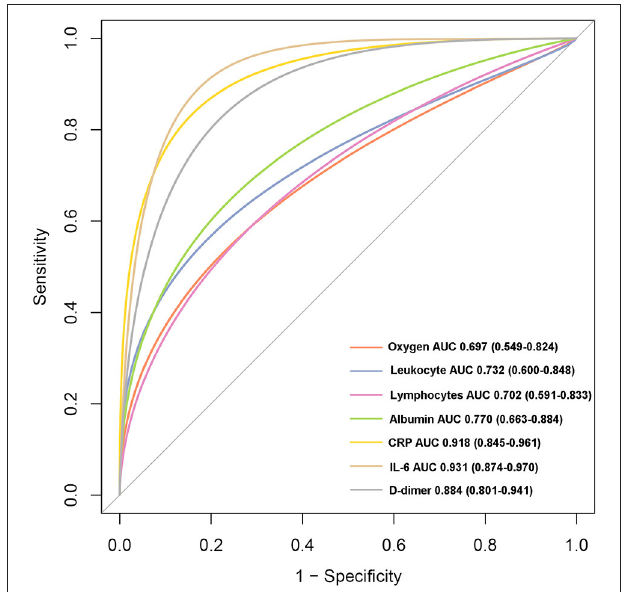
FIGURE 3 | The receiver operating curve (ROC) analysis for the seven indicators between critical and non-critical